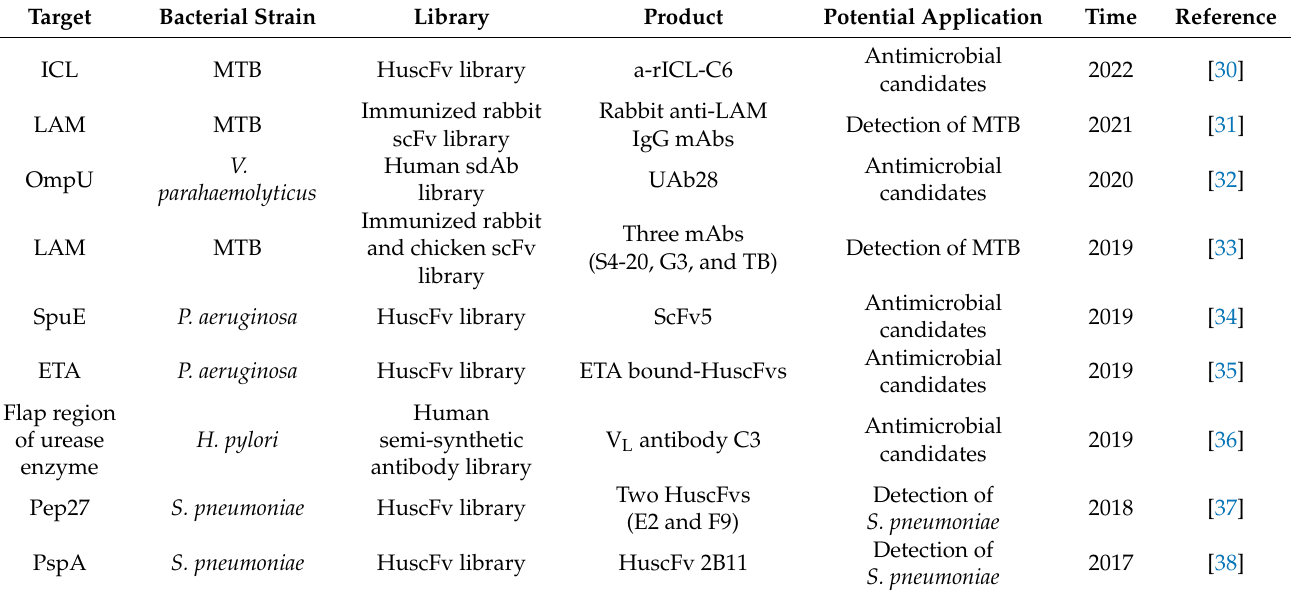
Table 2. Application of antibody phage display technology in antibacterial